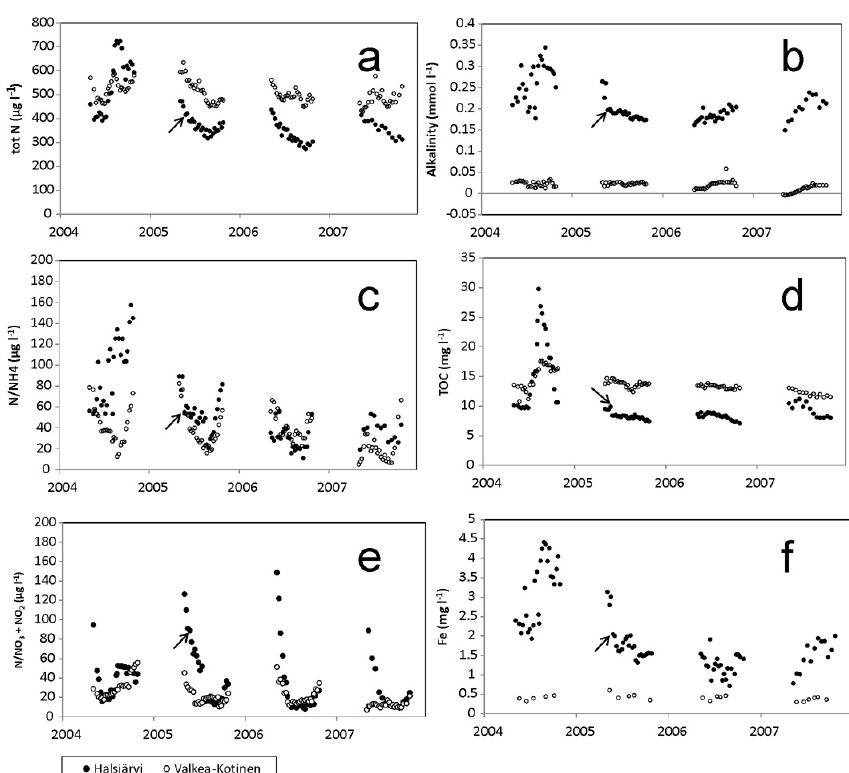
Fig. 8. Volume-weighted whole-lake concentrations of (a) totN, (b) alkalinity, (c) N/NH 4 , (d) TOC, (e) N/NO 3 and (f) Fe in lakes Halsj¨arvi (experimental lake) and Valkea-Kotinen (reference lake). The artificial mixing was conducted in Halsj¨arvi in 2005–2006 (reference years 2004, 2007). The arrow indicates the first sample taken after the start of the manipulation experiment in